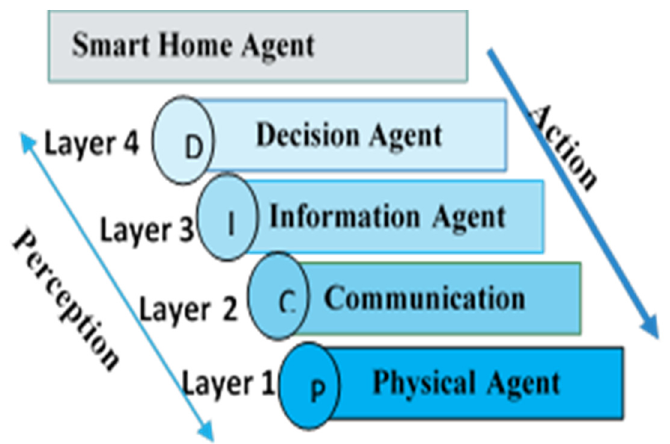
Figure A3. Smart Home agent architecture.